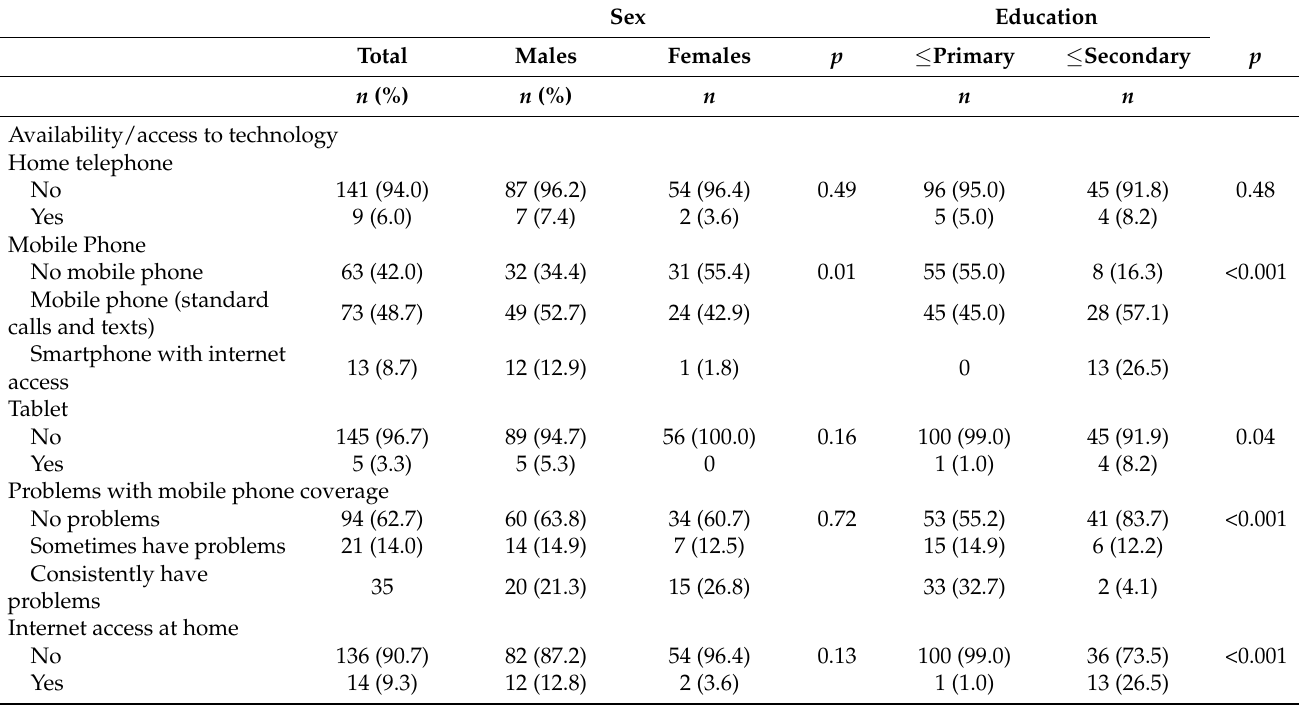
Table 2. Availability of or access to technology and technology use in last month for older adult patients from JSS hospital catchment area in rural